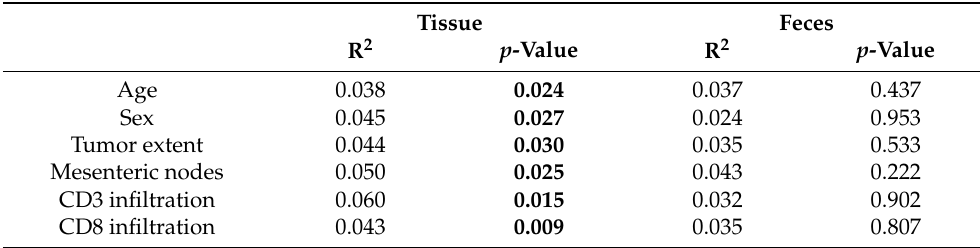
Table 3. Fecal and tissue microbiota beta diversity associations ( p -values and R 2 ) with tumor extent,